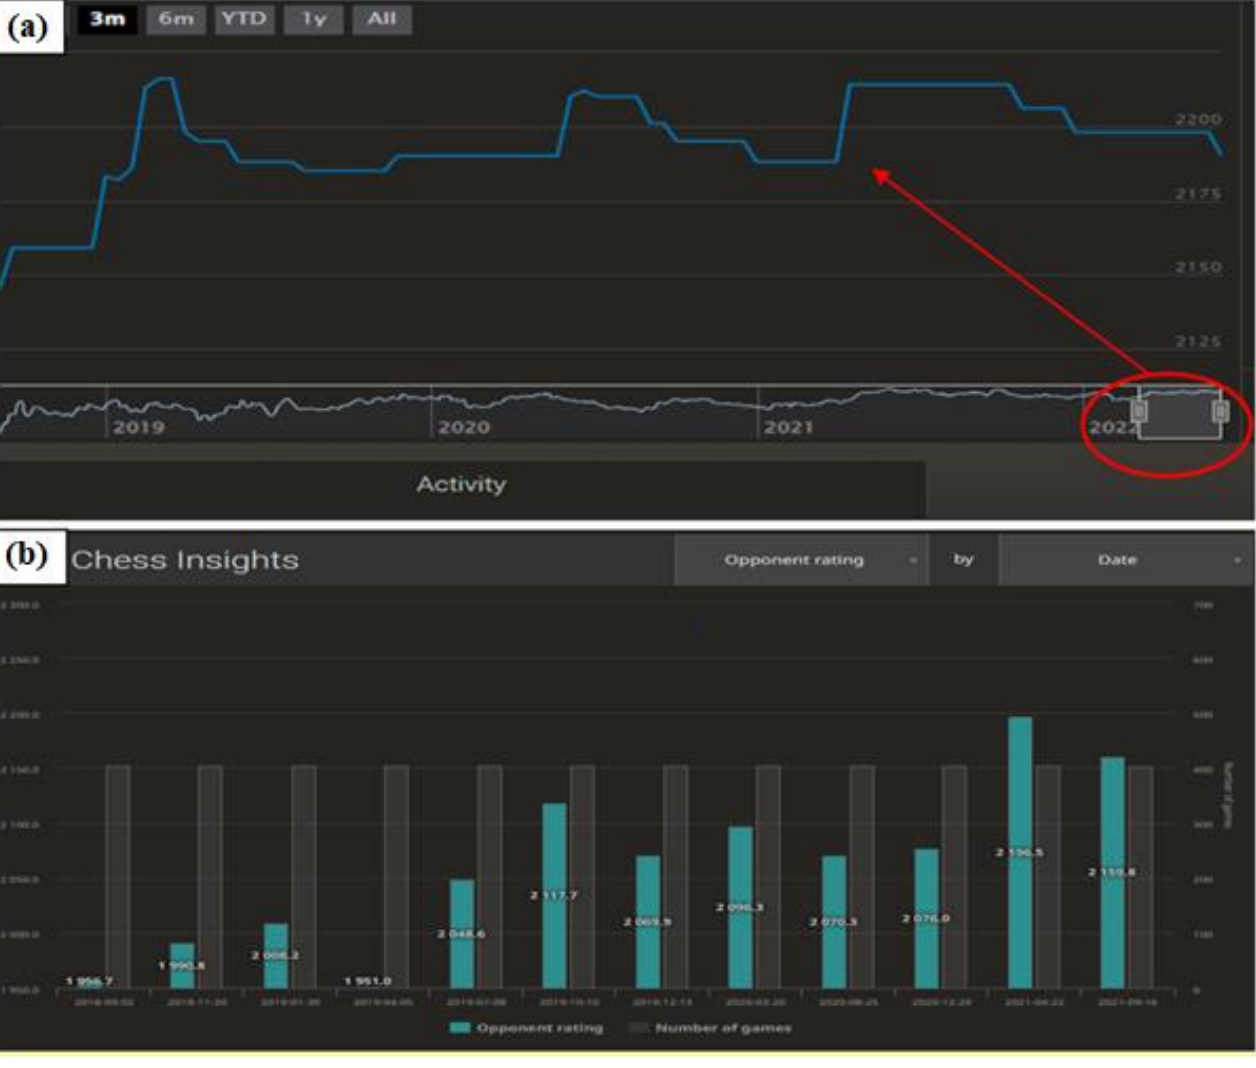
Figure 7. The results of the attained chess ranking on the Lichess platform ( a ) and the correlation of the average ranking of the opponents in different time intervals ( b ). Source: lichess.org.